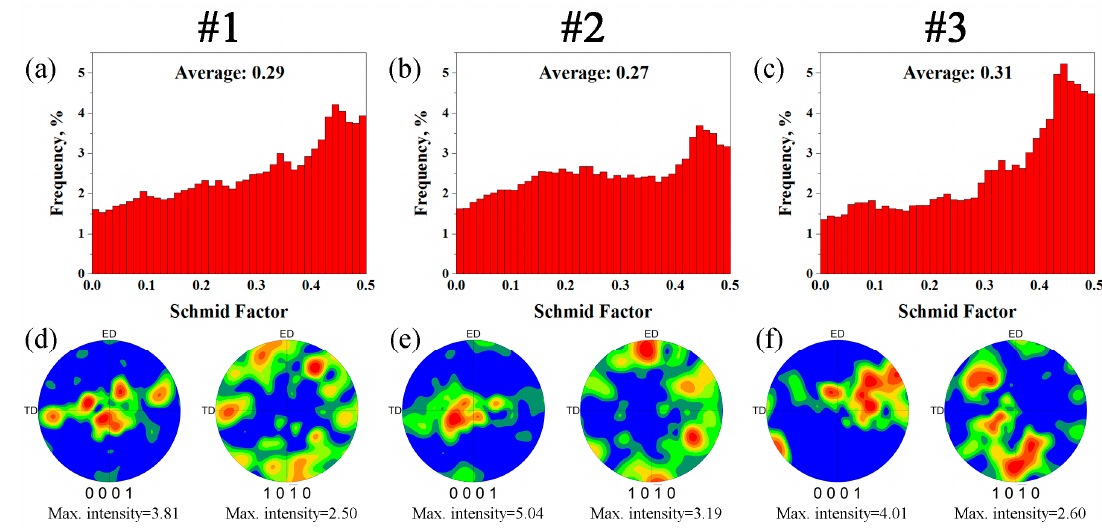
Figure 7. (0001) <11–20> Schmid factor distribution histograms ( a – c ) and pole figures ( d – f ) of the edge of sample #1 ( a , d ), #2 ( b , e ) and #3 ( c , f